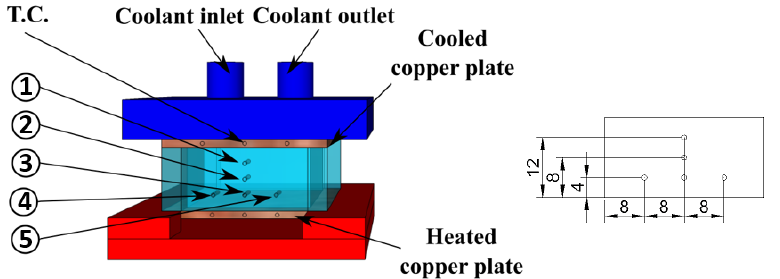
Figure 3. Experimental enclosure and exact placement of the thermocouples in the working fluid.